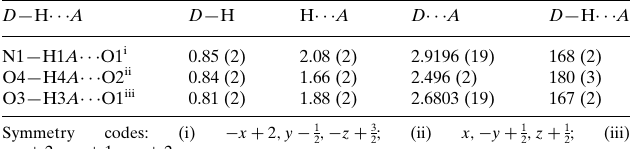
Hydrogen-bond geometry (A˚ , (cid:3)